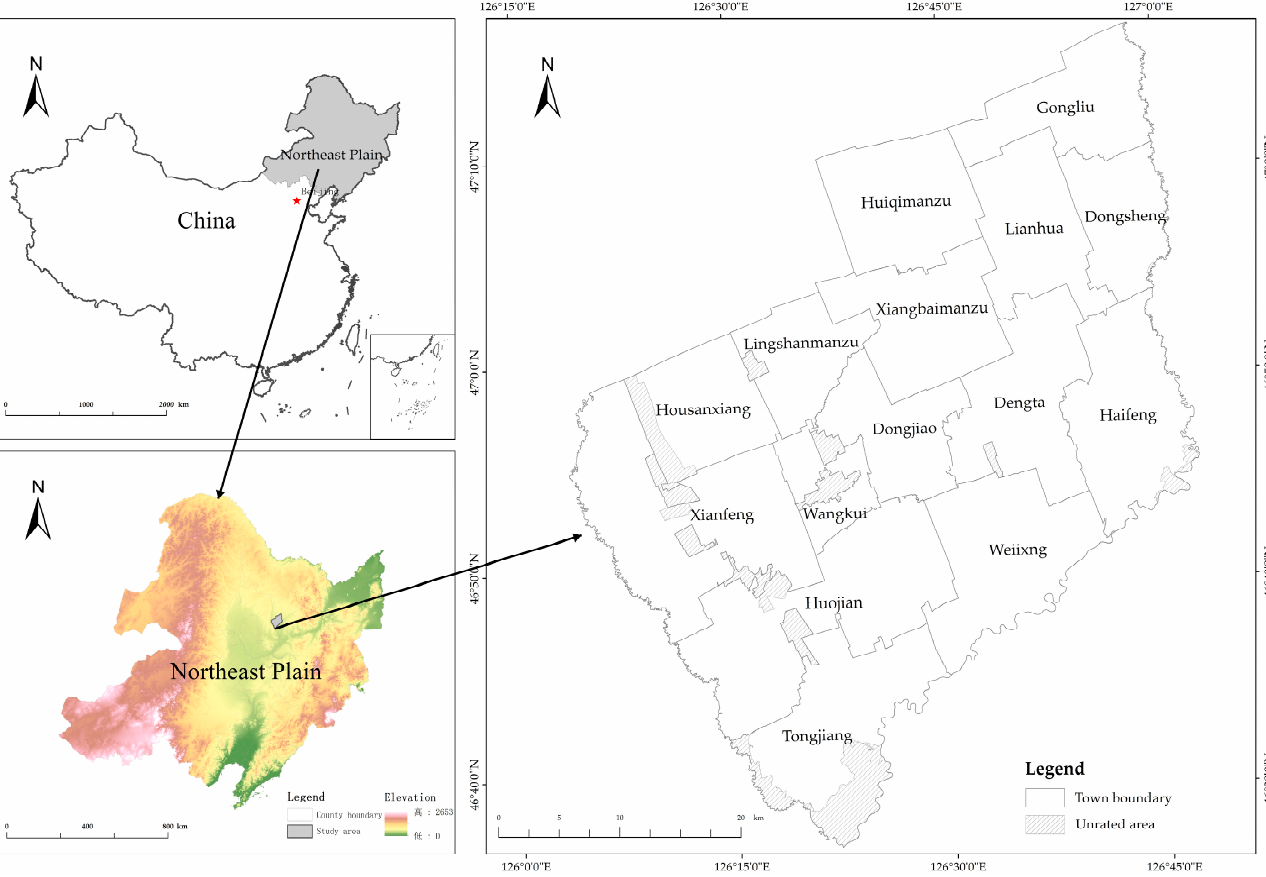
Figure 1. Location map of the study area. Unrated area represents the urban center and forest farm.